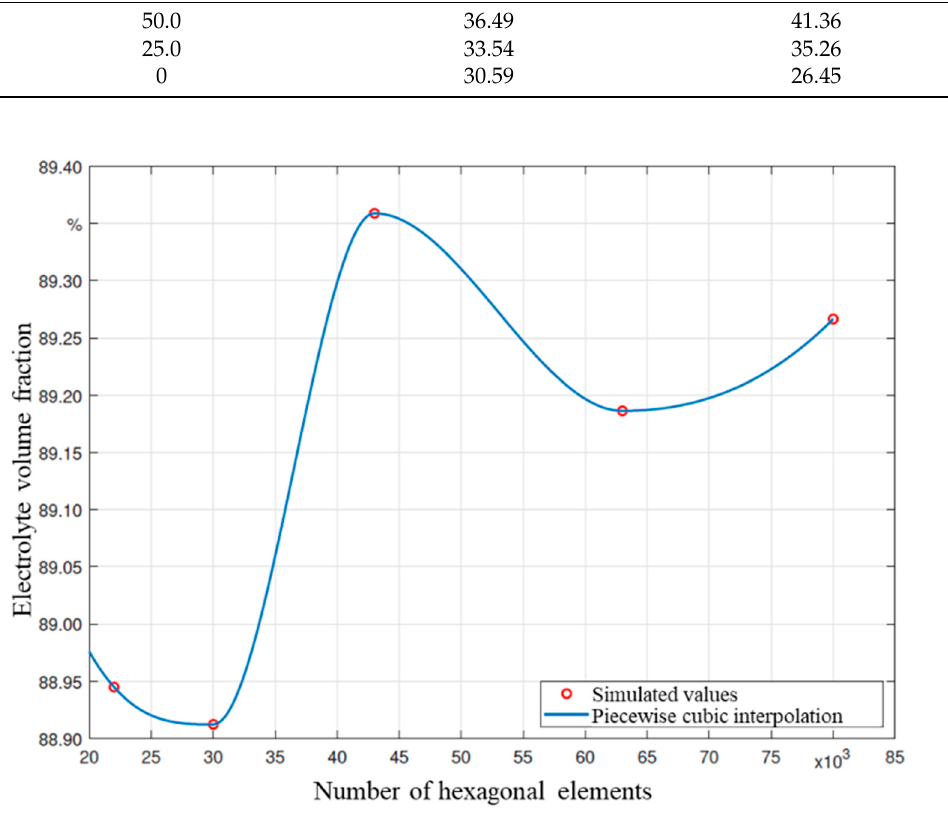
Figure A1. Results of a convergence study of the mesh used for the macro simulations under initial pressure ( p init = 100 mbar), gauge pressure ( p gauge = 1000 mbar) and temperature of the electrolyte (T = 25 °C).